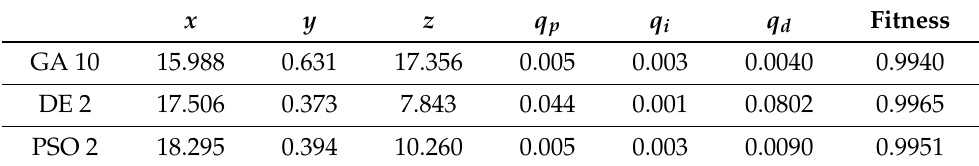
Table 4. Best set of parameters considering the highest fitness found by each